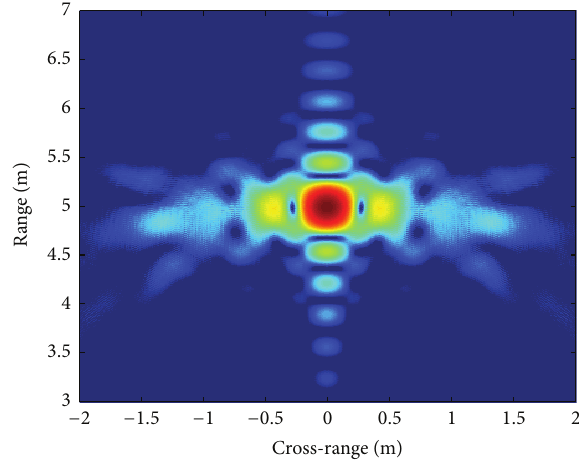
Figure 8: The target imaging result.